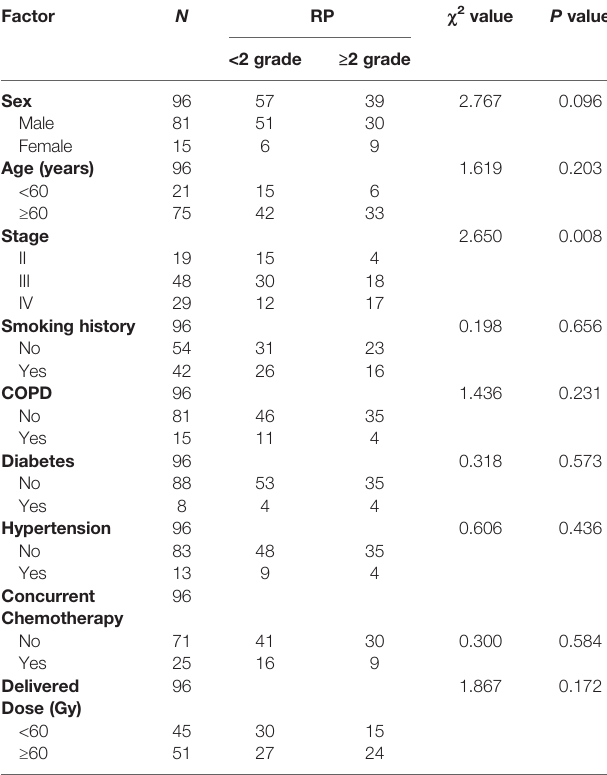
TABLE 1 | Univariate analysis of baseline clinical features of patients and RP.